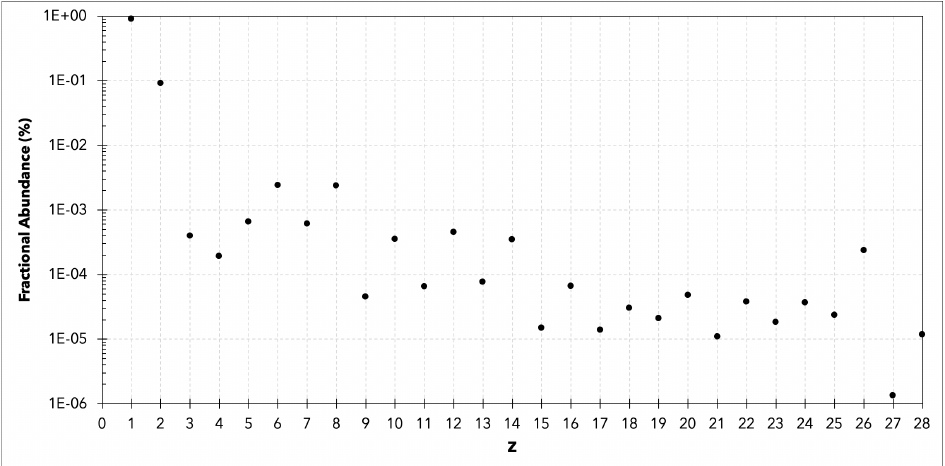
Figure 1. The relative abundance of each incident GCR ion simulated in this work obtained from [17] for solar modulation of 400